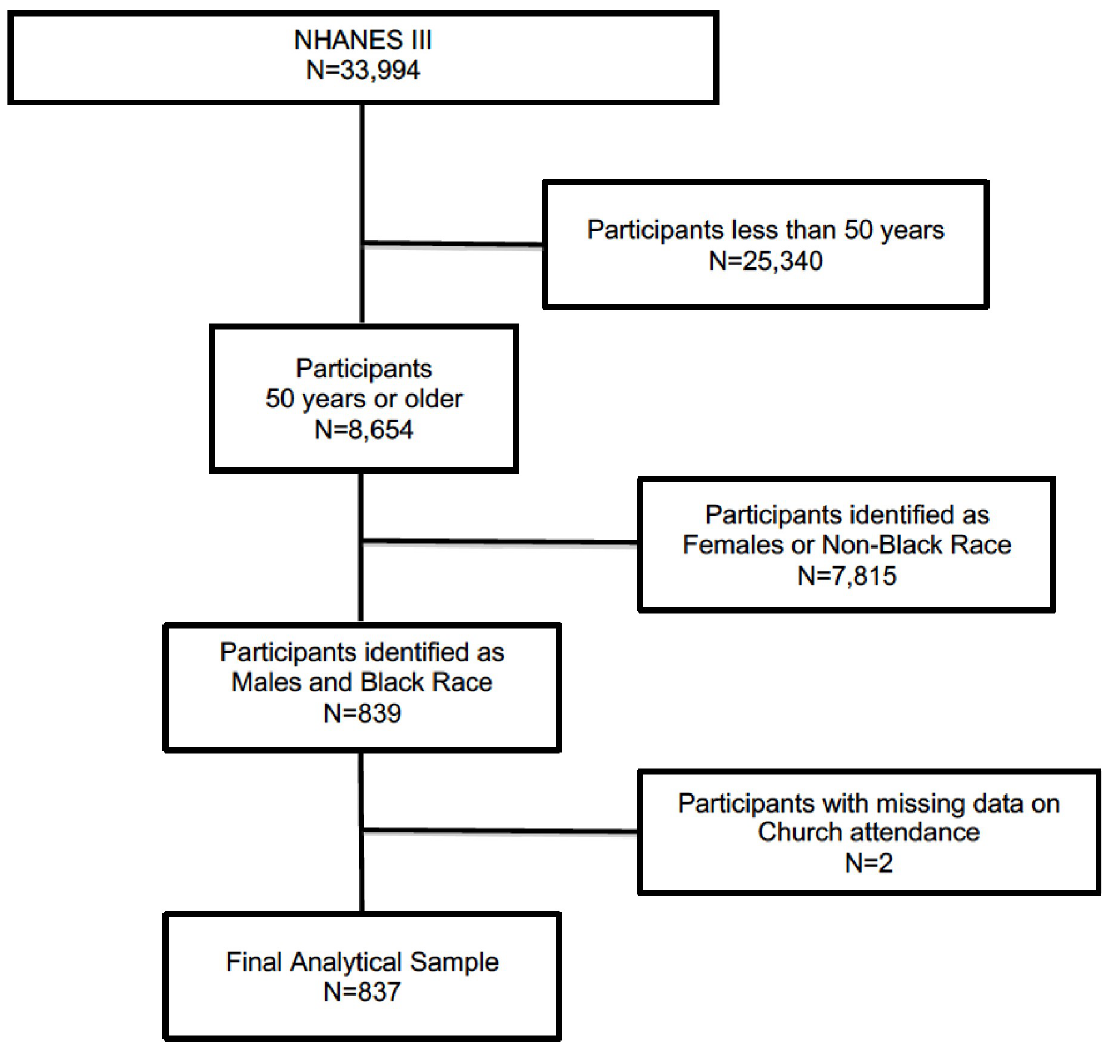
Fig 1. Algorithm used to define the study